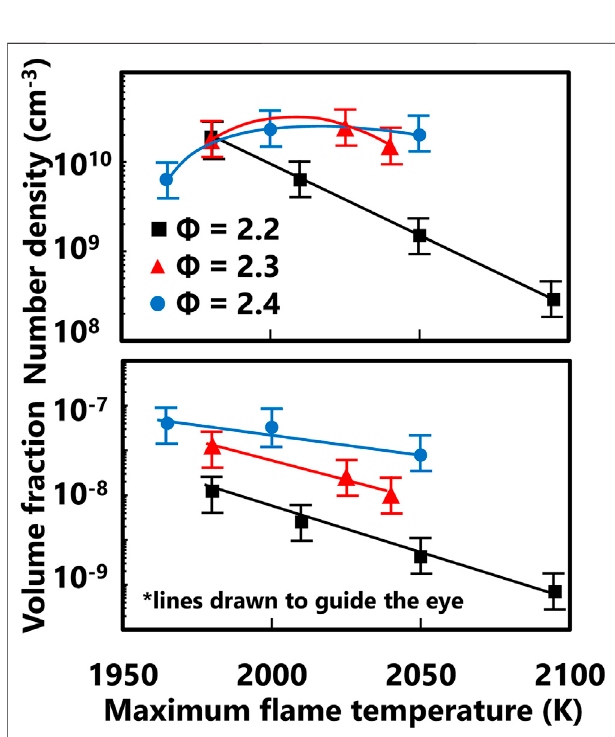
FIGURE 4 | Global particle distribution properties derived from the measured PSDF. Lines are drawn to guide the eye.